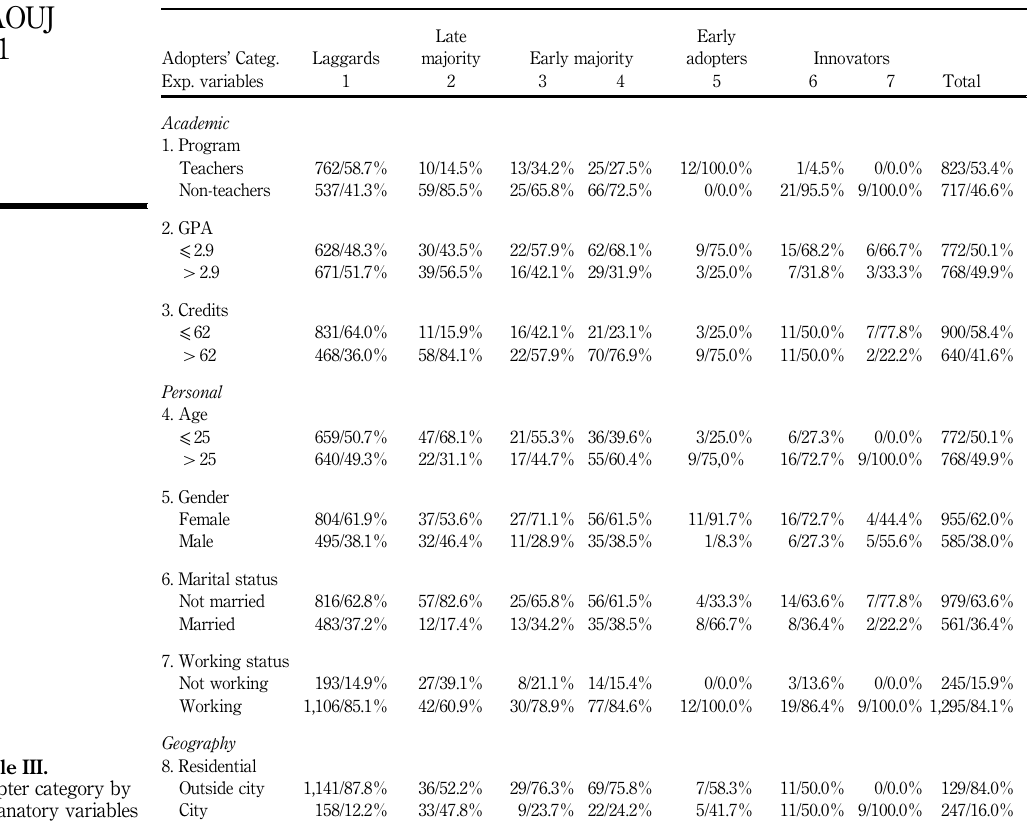
Table III. Adopter category by explanatory